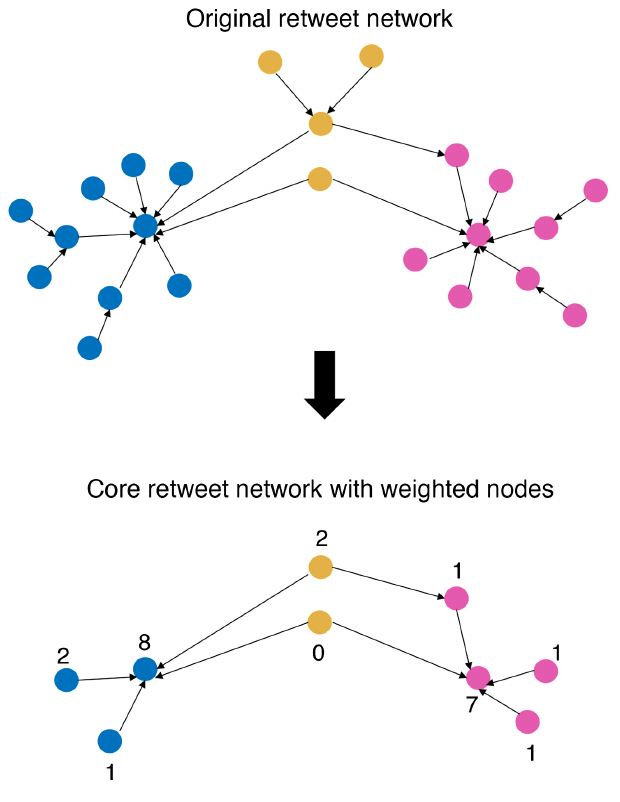
FIG. 8. Data-processing method of retweet networks. Define the weight of each node as the total number of times it is retweeted. In the largest connected component, we get rid of those “ pure followers ” who are not being retweeted (in degree equal to 0) and retweet others only once (out degree equal to 1) and plot the remaining retweet network with all nodes ’ weights recorded. The simplified retweet network has all the important information and better represents the core structural